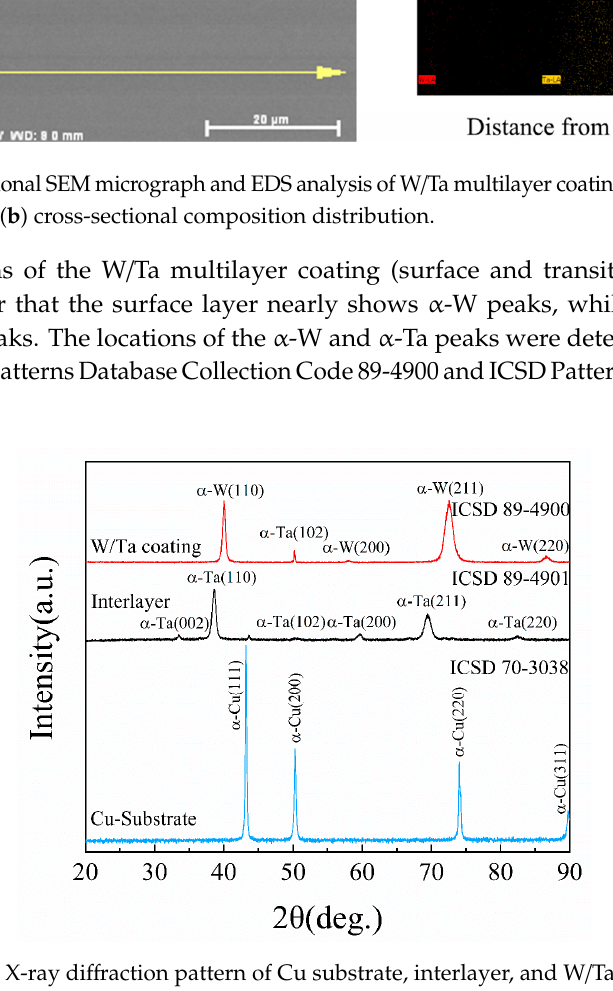
Figure 4. X-ray diffraction pattern of Cu substrate, interlayer, and W/Ta coating.